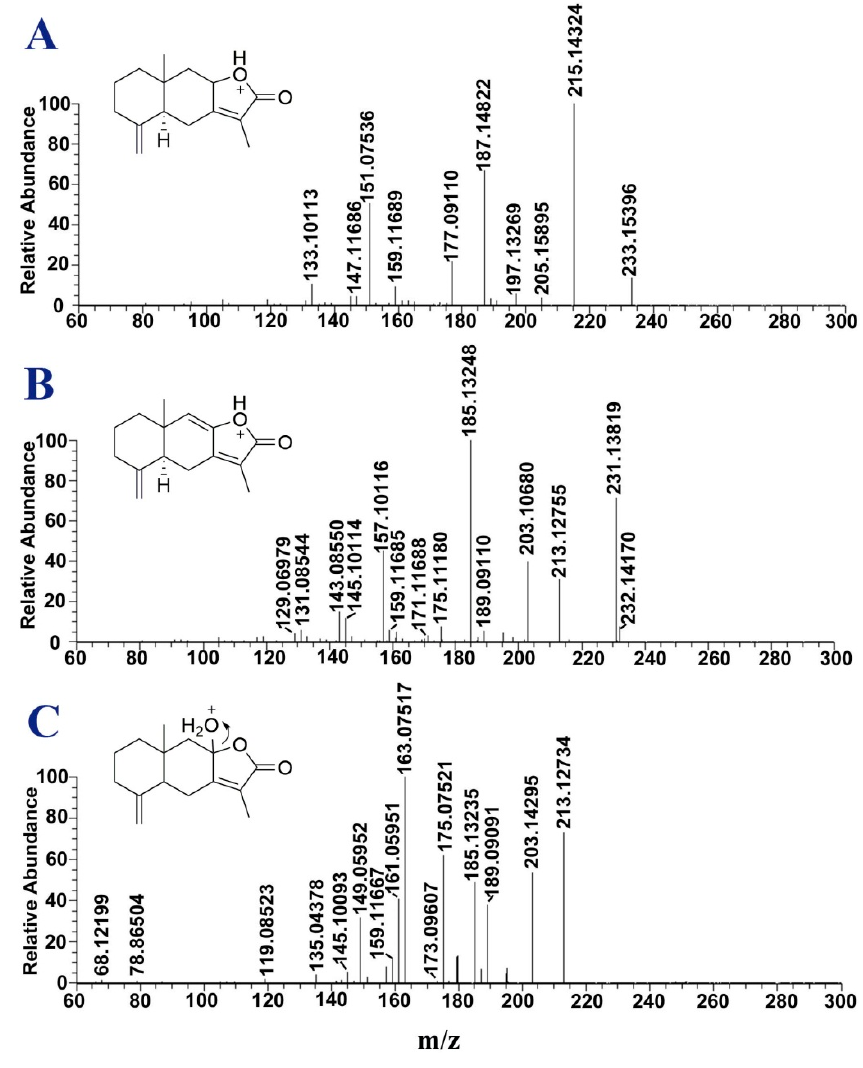
Figure 3. MS n spectra of atractylenolide I ( A ); atractylenolide II ( B ) and atractylenolide III ( C ).